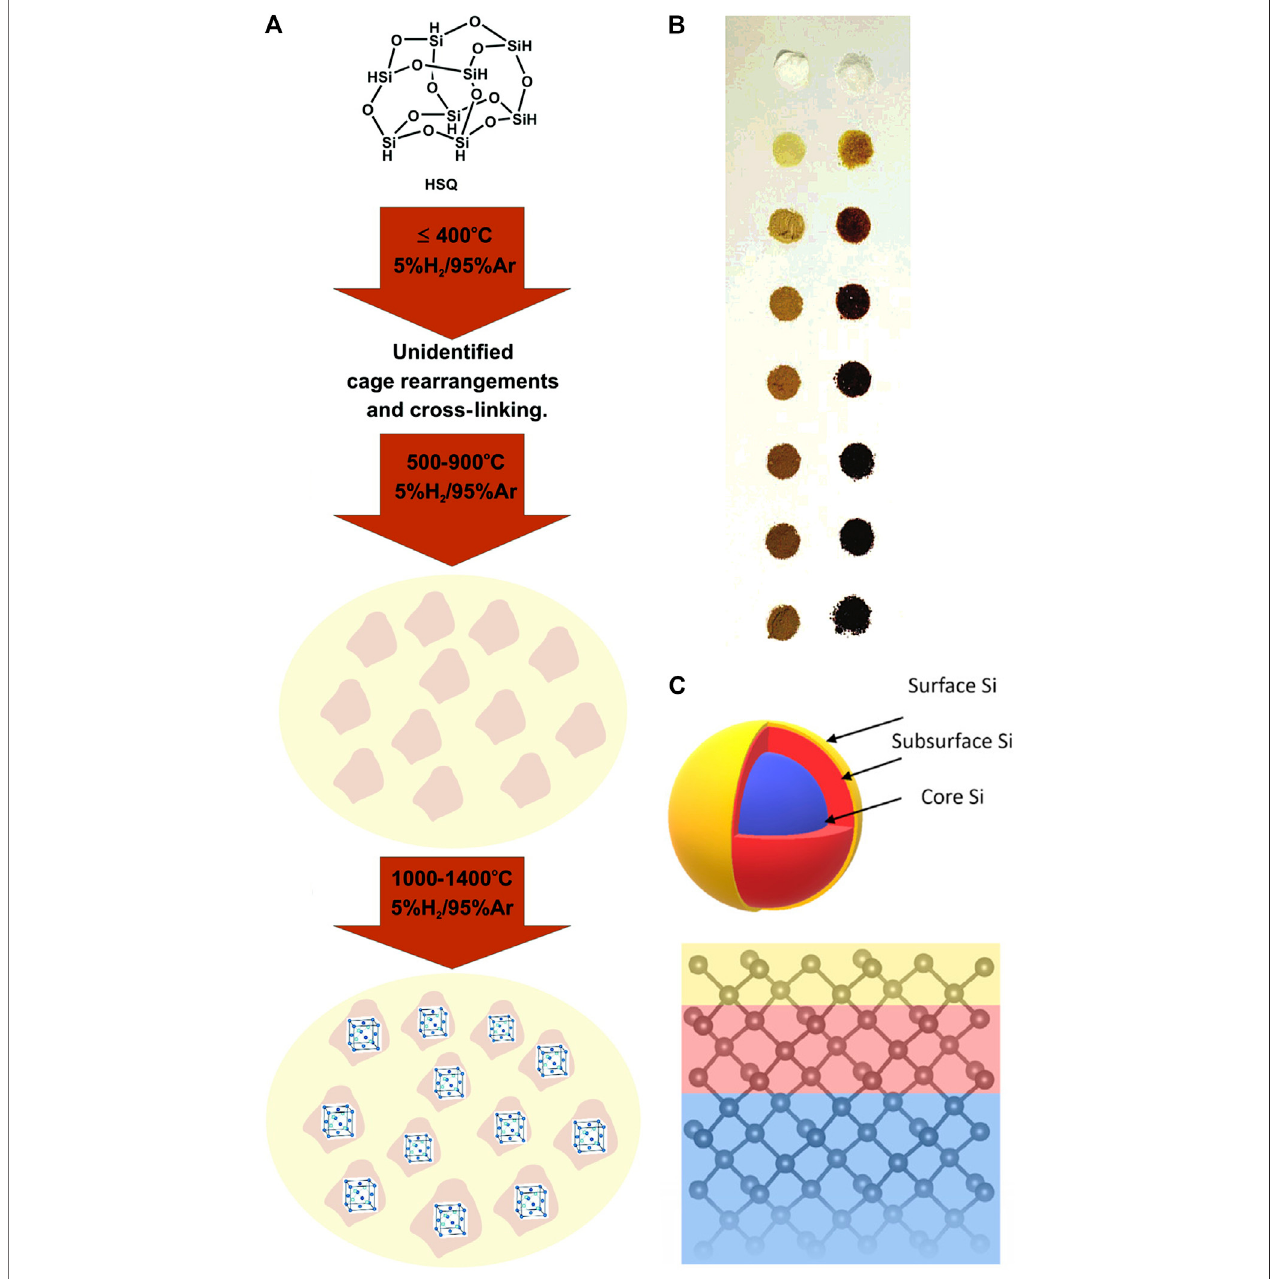
FIGURE 1 | (A) Three stages of the thermal disproportionation process from room temperature to 1,400 ° C for HSQ, reprinted with permission from Hessel et al. (2007). Copyright 2007 American Chemical Society. (B) Photographs of HSQ heated at 500, 600, 700, 800, 900, 1,000, and 1,100 ° C for an hour respectively (top to bottom) , as prepared (right) and fi nely ground (left) , reprinted with permission from Hessel et al. (2006). Copyright 2006 American Chemical Society. (C) Schematic diagram of core-shell structured SiNCs with a model of the fi rst ten atomic layers, reprinted with permission from Thiessen et al. (2019). Copyright 2019 American Chemical